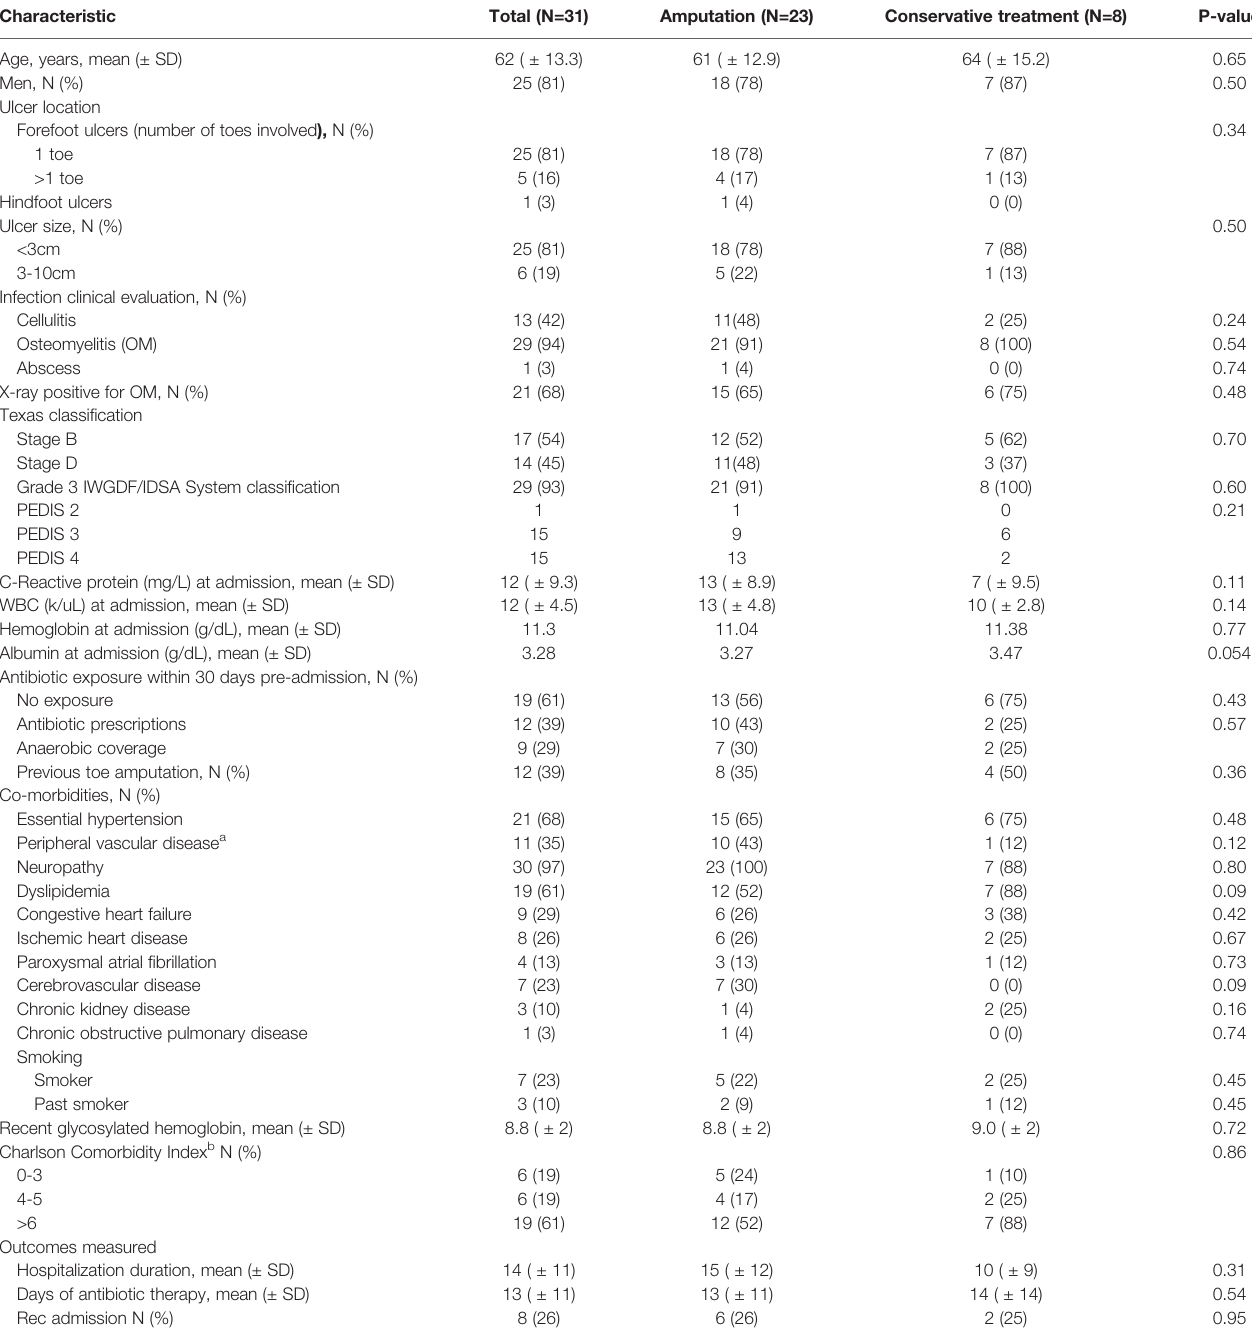
TABLE 1 | Patient characteristics at enrolment and clinical outcomes